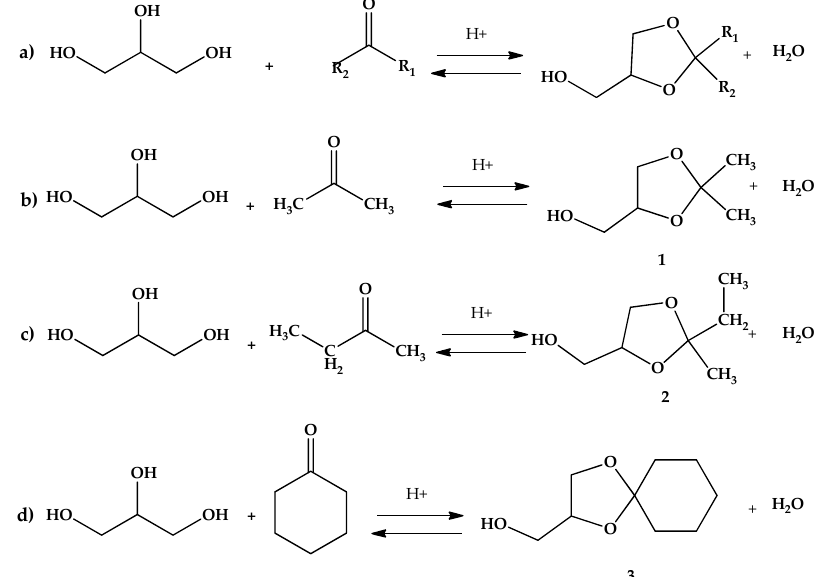
Figure 2. Reactions of acid-catalyzed of glycerol ketalization: ( a ) general ketalization; ( b ) System 1: ketalization of glycerol with acetone to 2,2-dimethyl-1,3-dioxolane-4-methanol (solketal or ketal 1); ( c ) System 2: ketalization of glycerol with MEK to 2-ethyl-2-methyl-1,3-dioxolane-4-methanol (ketal